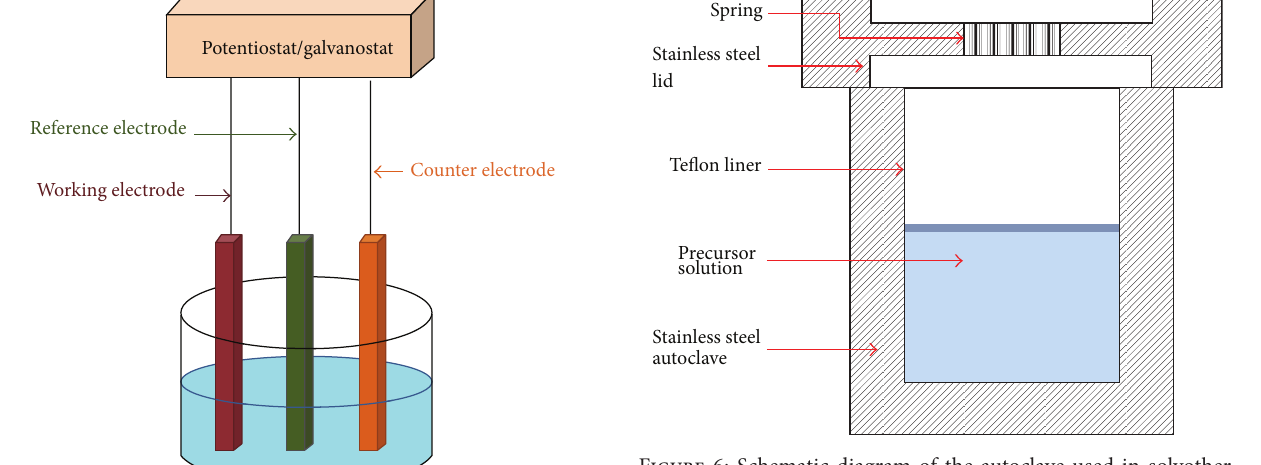
Figure 6: Schematic diagram of the autoclave used in solvother- mal/hydrothermal synthesis